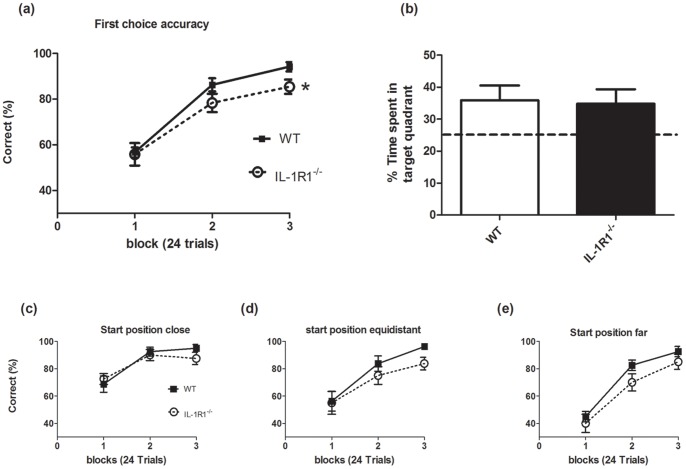
Spatial memory and choice performance on the spatial-discrimination beacon water maze task in IL-1R1−/− and WT mice.IL-1R1−/− and WT mice (n = 10) were trained (8 trials per day for 12 days) to discriminate between two identical beacons (diameter 15 cm; 24 cm high, sitting on the water surface) depending on their spatial locations, one of which had a hidden platform underneath. 1 block = 24 trials. a) First choice accuracy to choose the correct beacon was assessed. b) Probe test performed after 72 trials, with 25% depicted by dotted line. The percentage correct choices on choosing the correct beacon are shown when start position is c) close to correct beacon, d) equal distance from both beacons and e) furthest from correct beacon. * p<0.05 by one-tailed t-test comparison of first choice accuracy across all trials. Data are expressed as mean±SEM and full statistical analysis is described in the text.